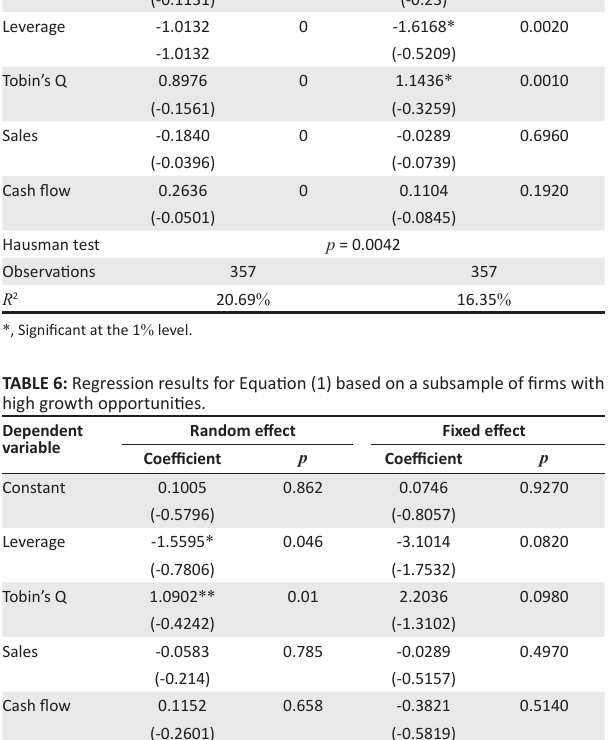
TABLE 5: Regression results for Equation (1) using total liabilities as a proxy of leverage. Dependent variable